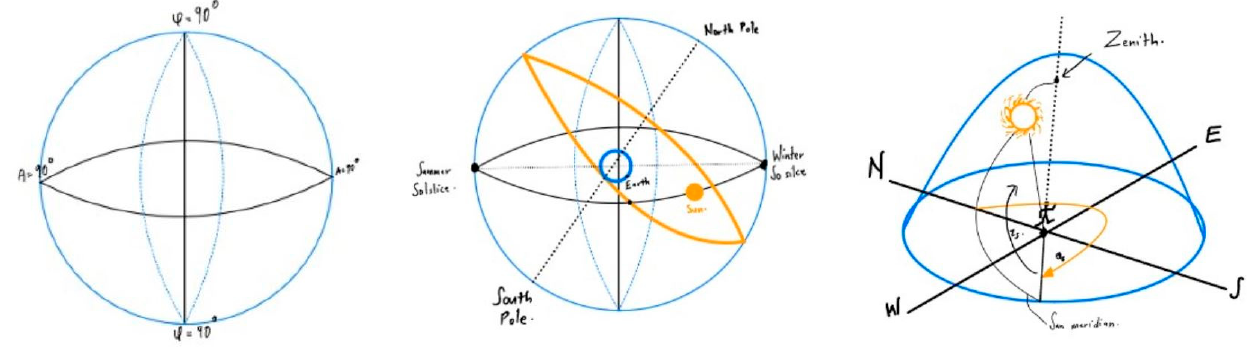
Figure 2. Position of the sun, latitude, and longitude [1,9].